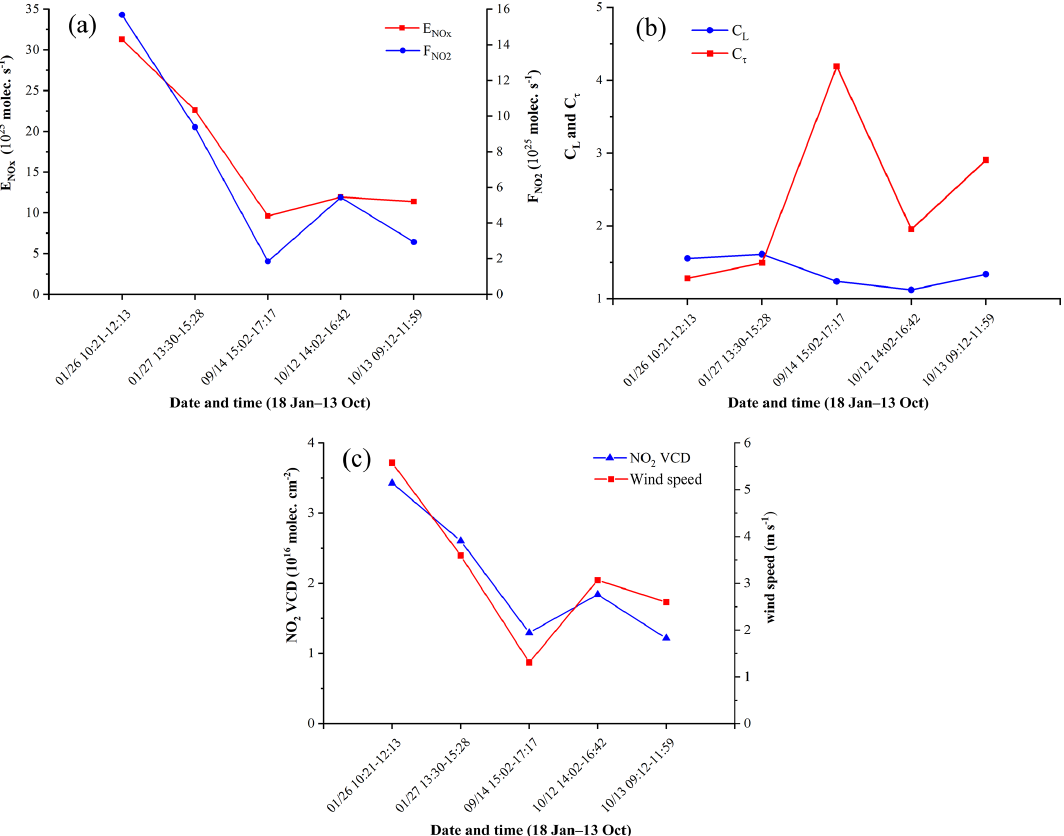
Figure 9. Journey-to-journey variations in (a) F NO journeys on the 6th Ring Rd of Beijing in January, September, and October